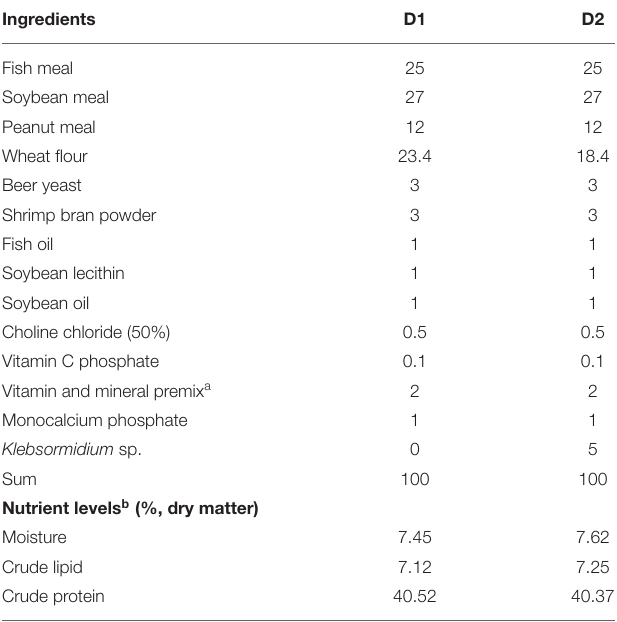
TABLE 2 | Ingredients and proximate compositions of two experimental diets (%, dry